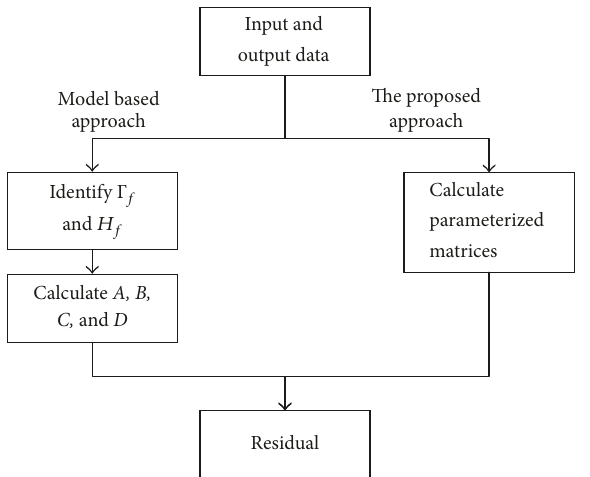
Figure 1: Model-based approach and the proposed